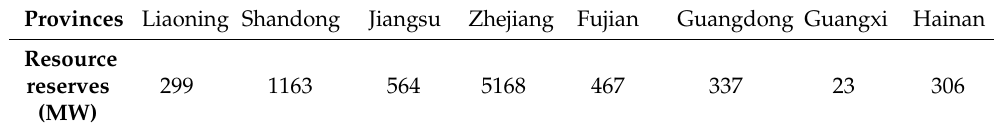
Table 3. Tidal current energy resource reserves of several key provinces in 2004 national assessment [16].